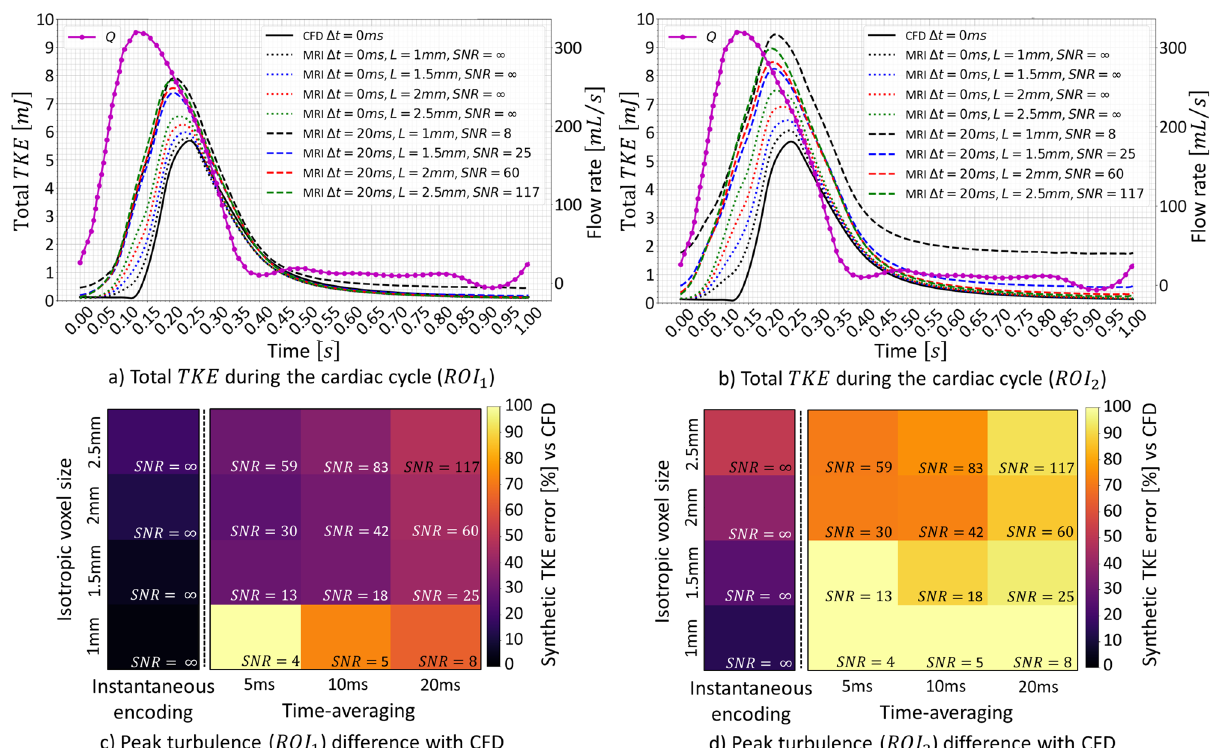
Figure 4. Impact of SNR and spatiotemporal resolution on time-resolved turbulent kinetic energy for a 75% eccentric stenosis and pulsatile flow. Time-resolved total TKE and flow rate ( Q ) during a simulated cardiac cycle for varying voxel sizes ( L ) , time averaging (� t ) and, correspondingly, signal-to-noise ratios ( SNR ) for ROI 1 ( a ) and ROI 2 ( b ) (see Fig. 3). Errors in total TKE integrated during the cardiac cycle ROI 1 ( c ) and ROI 2 ( d ). Instantaneous ( (cid:31) t = 0 ms ) encoding refers to a hypothetical noise-free PC-MRI experiment with infinitely high velocity encoding